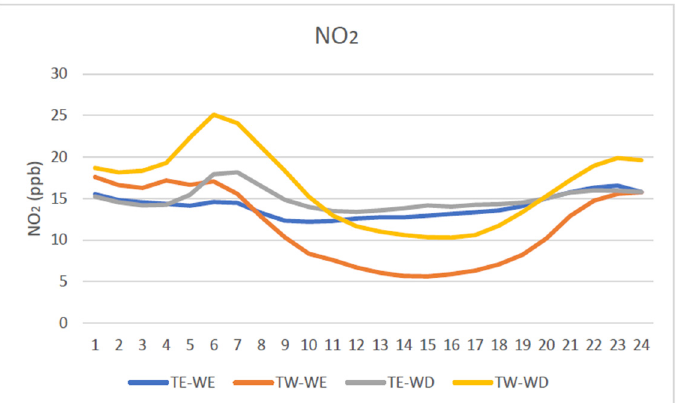
Figure 3. Nitrogen dioxide concentration (ppb) during the baseline period (2010–2019) for Toronto West (TW) and Toronto East (TE) for weekends (WE) and weekdays (WD).